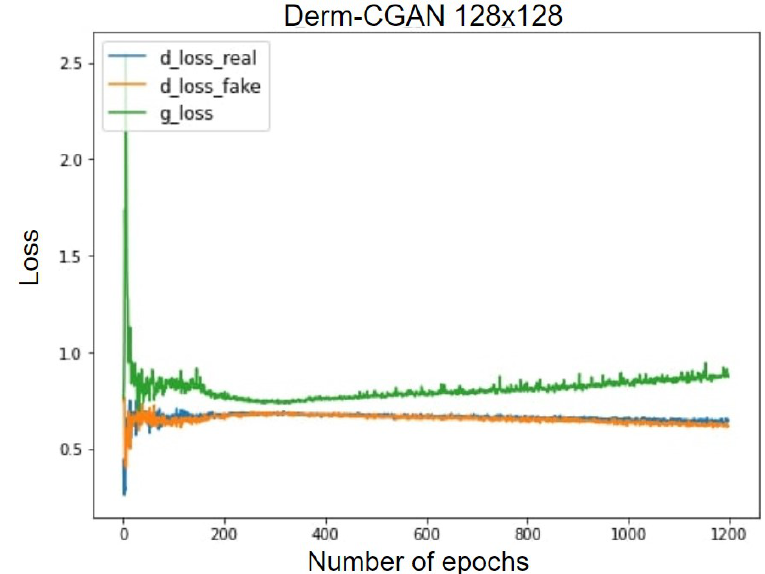
Figure 11. Generator and discriminator losses of